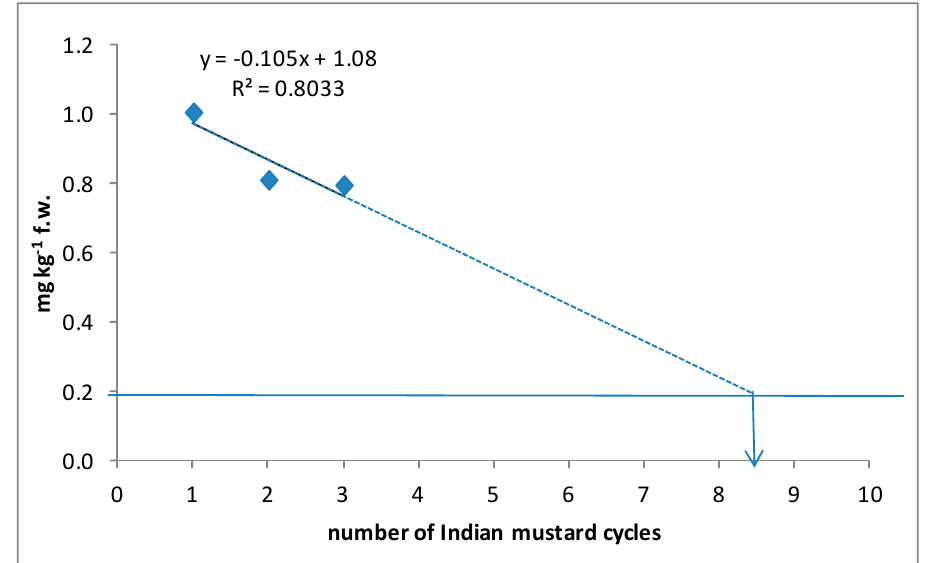
Figure 5. Projection of Cd concentration in Rocket salad (on the average of the year) in relation to the number of phytoextraction cycles by Indian mustard.